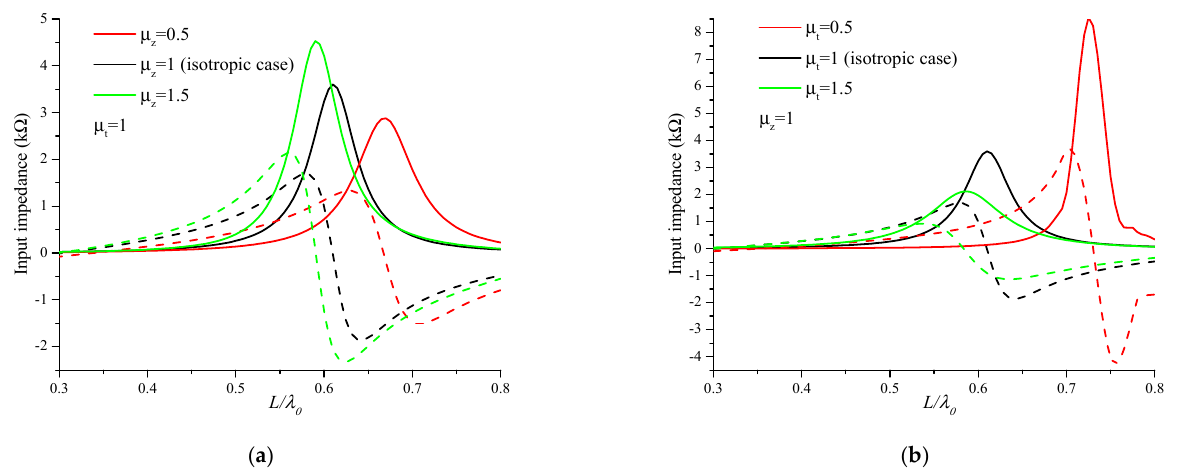
Figure 13. Real and imaginary parts of the input impedance for various values of ( a ): µ z and ( b ): µ z .